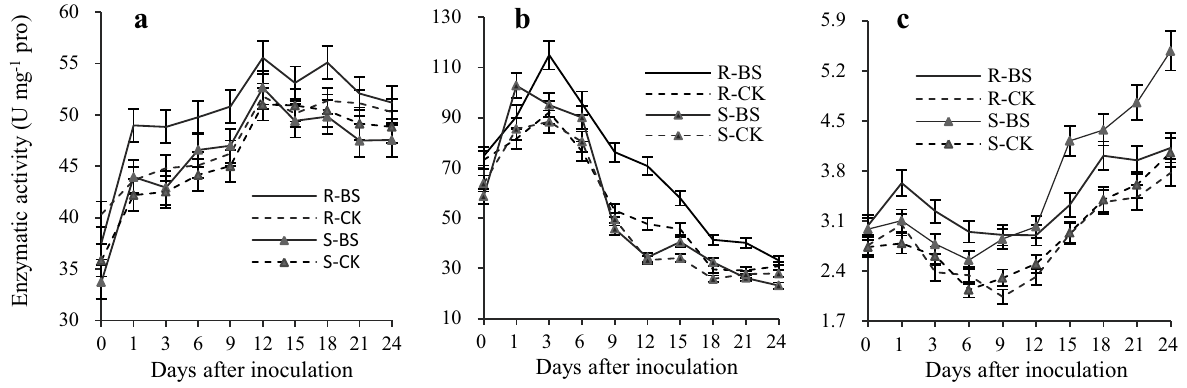
Figure 6. Activities of antioxidant enzymes in kernels from slightly and highly susceptible wheat lines inoculated with Bipolaris sorokiniana . ( a ) Superoxide dismutase (SOD); ( b ) catalase (CAT); ( c ) peroxidase (POD); The number 0, 1, 3, 6, 9, 12, 15, 18, 21 and 24 indicate the different days after inoculation. R and S are the slightly susceptible (SN4143) and highly susceptible (PZSCL6) line, respectively. Bs and CK represent the samples inoculated with B. sorokiniana and those treated with sterile distilled water,